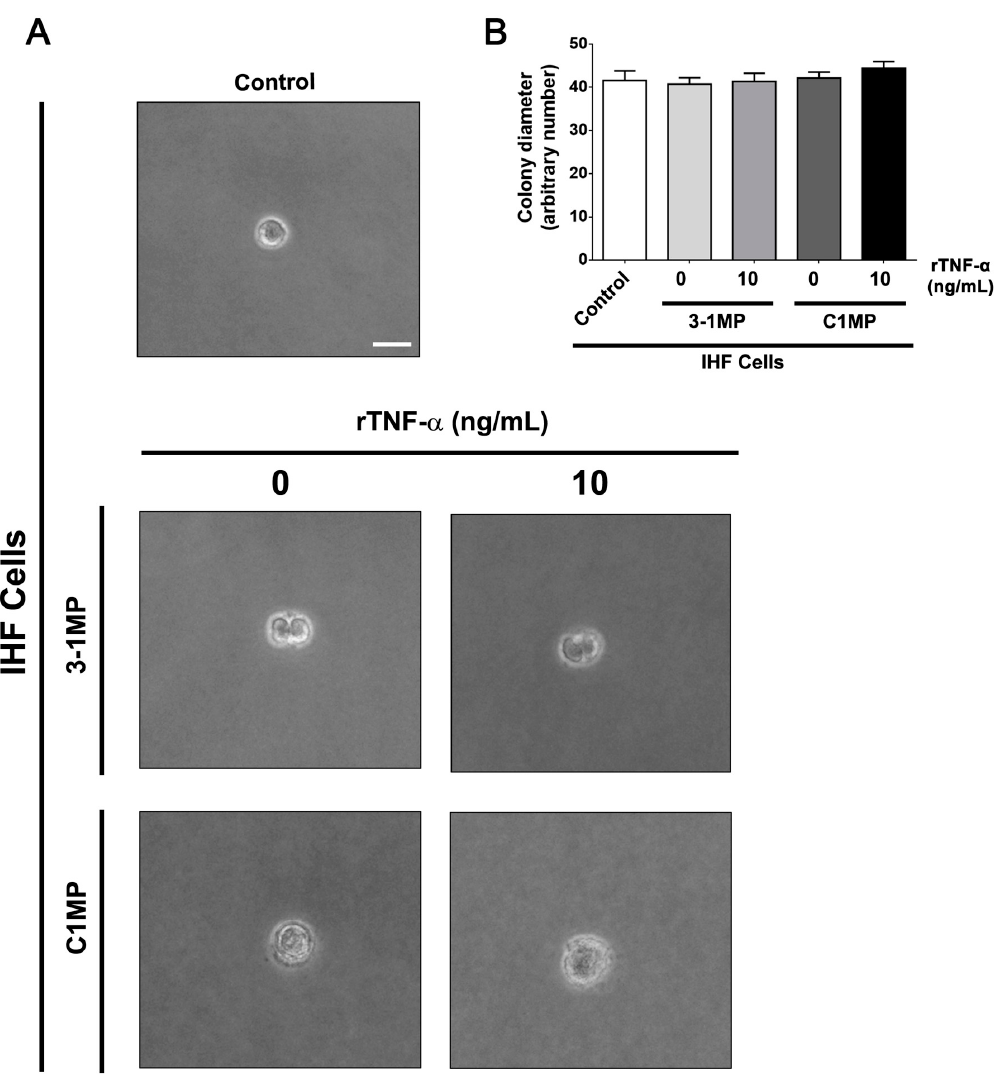
Figure 7. Analysis of IHF colony formation after incubation with microparticles (MP) derived from parental and MDR cell lines. Semisolid-medium growth assay. Following co-culture with 3-1MP or C1MP, IHF cells were cultured in DMEM containing 0.6% agarose. After 18 days, ( A ) colonies were visualized by phase-contrast microscopy and ( B ) colonies’ diameter was measured. ( A ) Representative images of IHF colonies under each condition. Images were acquired using an Axio Observer.Z1, Zeiss, under 20 × magnification. Scale bar = 20 µ m. Data are means ± SD of three independent experiments. One-way ANOVA with Dunn’s posttest and t -tests were used to analyze colony formation assay